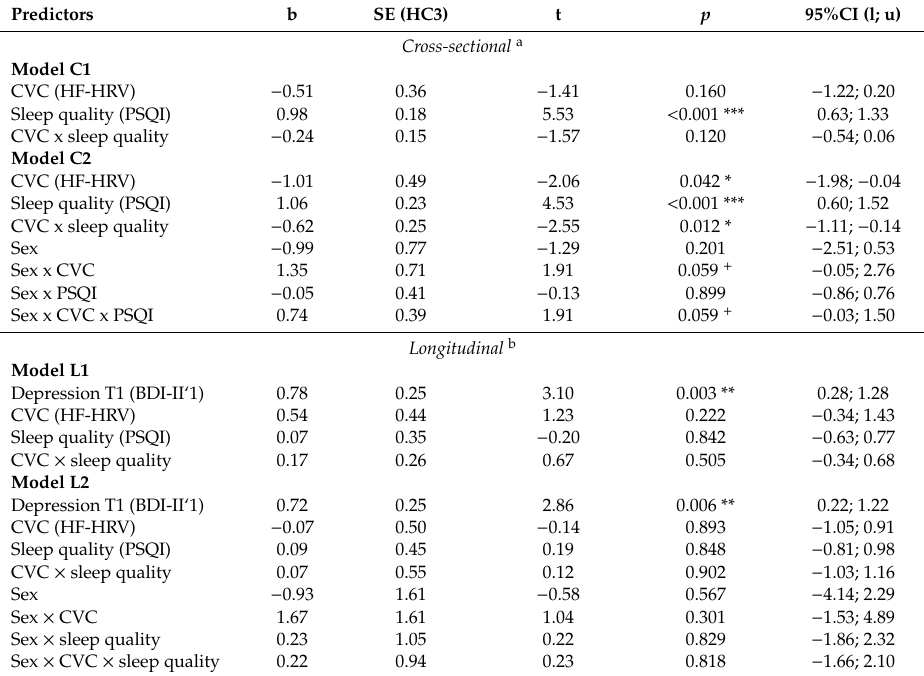
Table 2. E ff ects of CVC, subjective sleep quality, and their interaction on depressive